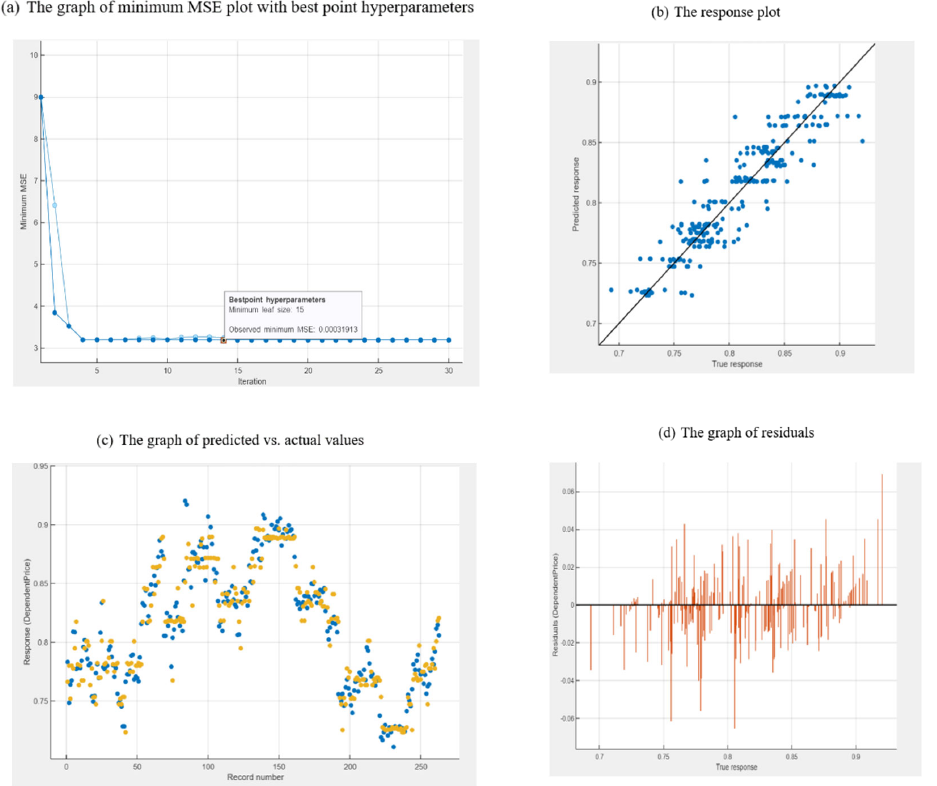
Fig. 8. Performance Graphs of Prediction Made with Regression Trees